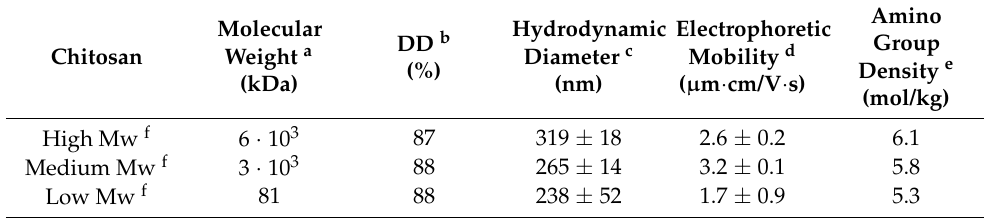
Table 1. Characteristics of the high, medium, and low molecular weight chitosans. Molecular Chitosan